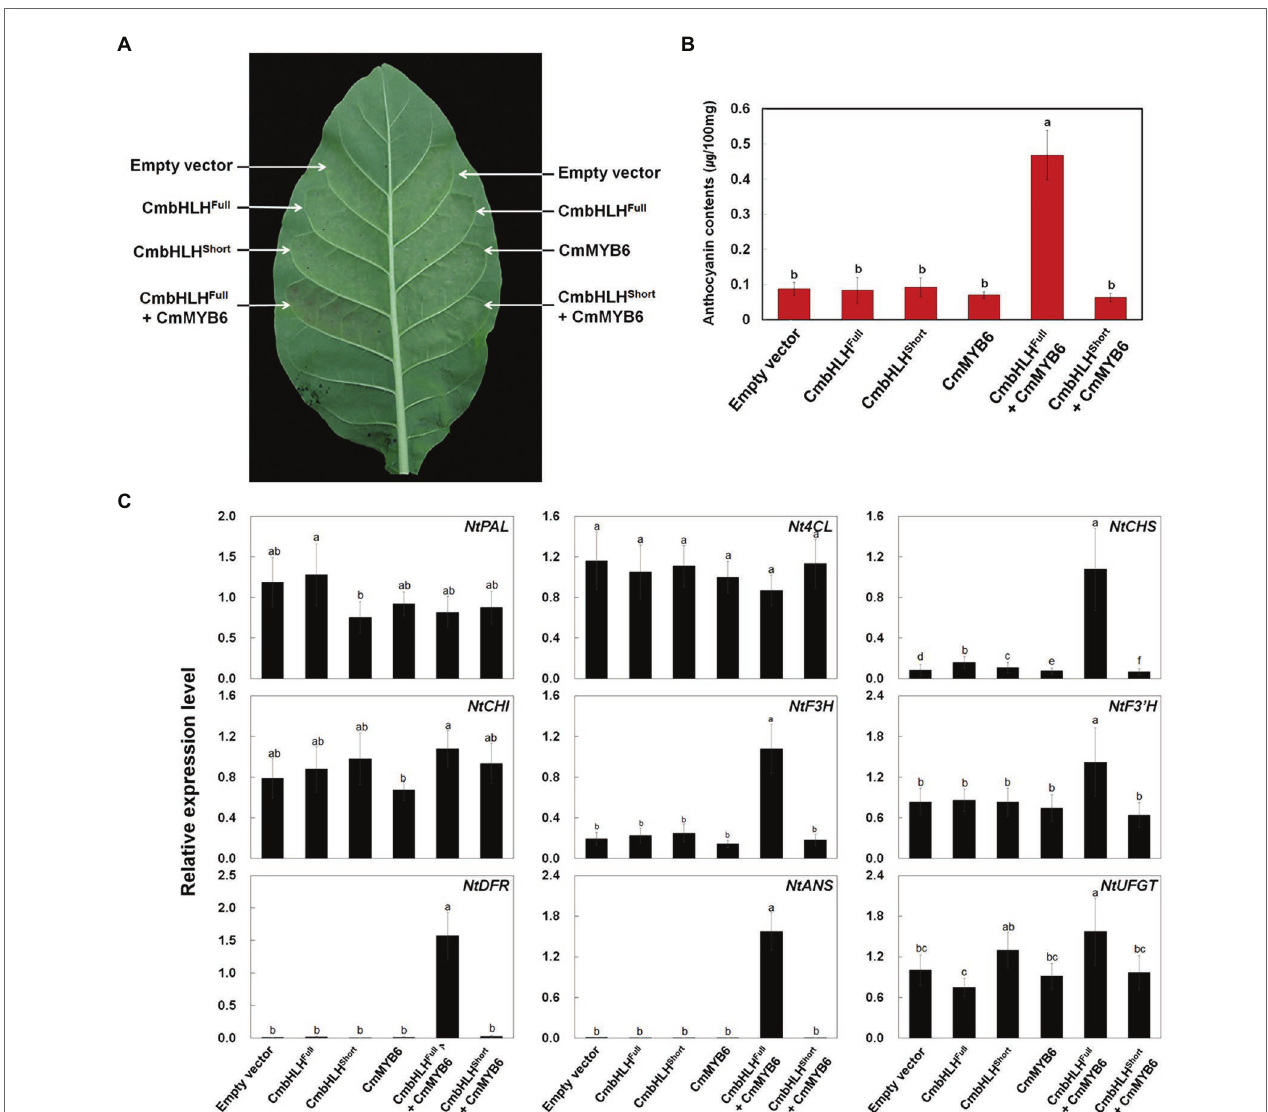
FIGURE 8 | Anthocyanin contents in transiently transformed tobacco leaves infiltrated with Agrobacterium strains carrying CmMYB6 , CmbHLH2 Full , and CmbHLH2 Short . (A) Images of transiently transformed tobacco leaves at 5 days after agroinfiltration. (B) Anthocyanin content was extracted from each patch after agroinfiltration. (C) Relative expression levels of endogenous anthocyanin biosynthetic genes in tobacco plants, as determined by qPCR analysis. Results represent mean values ± SD from three biological replicates. Different letters above the bars indicate significantly different values ( p < 0.0001) calculated using one-way ANOVA followed by Duncan’s multiple range